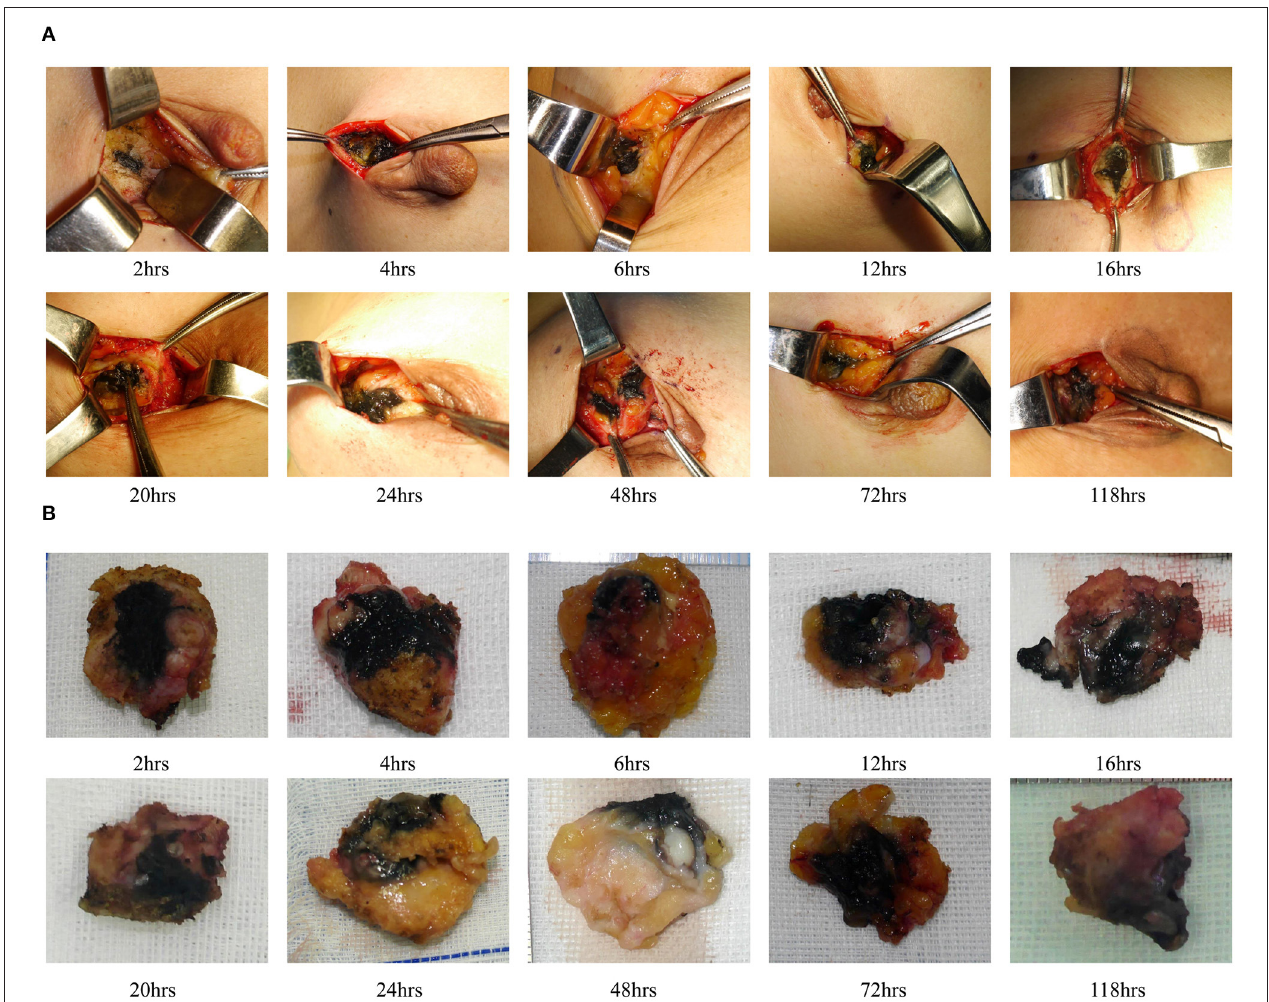
FIGURE 4 | Dyeing in CNSL group. (A) Dyeing track. (B) Resection